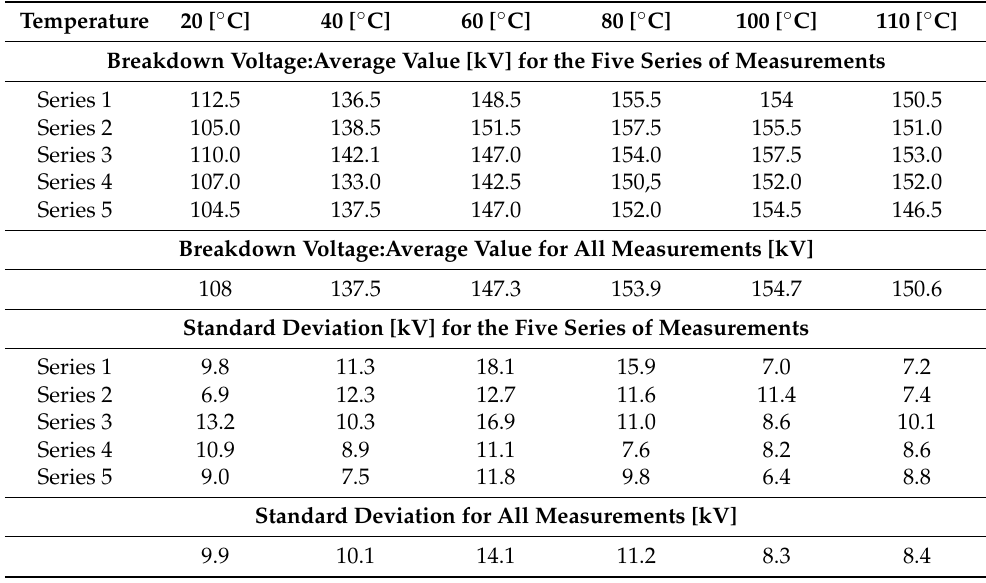
Table 2. Summary of average values of LI BDV and standard deviations at the selected